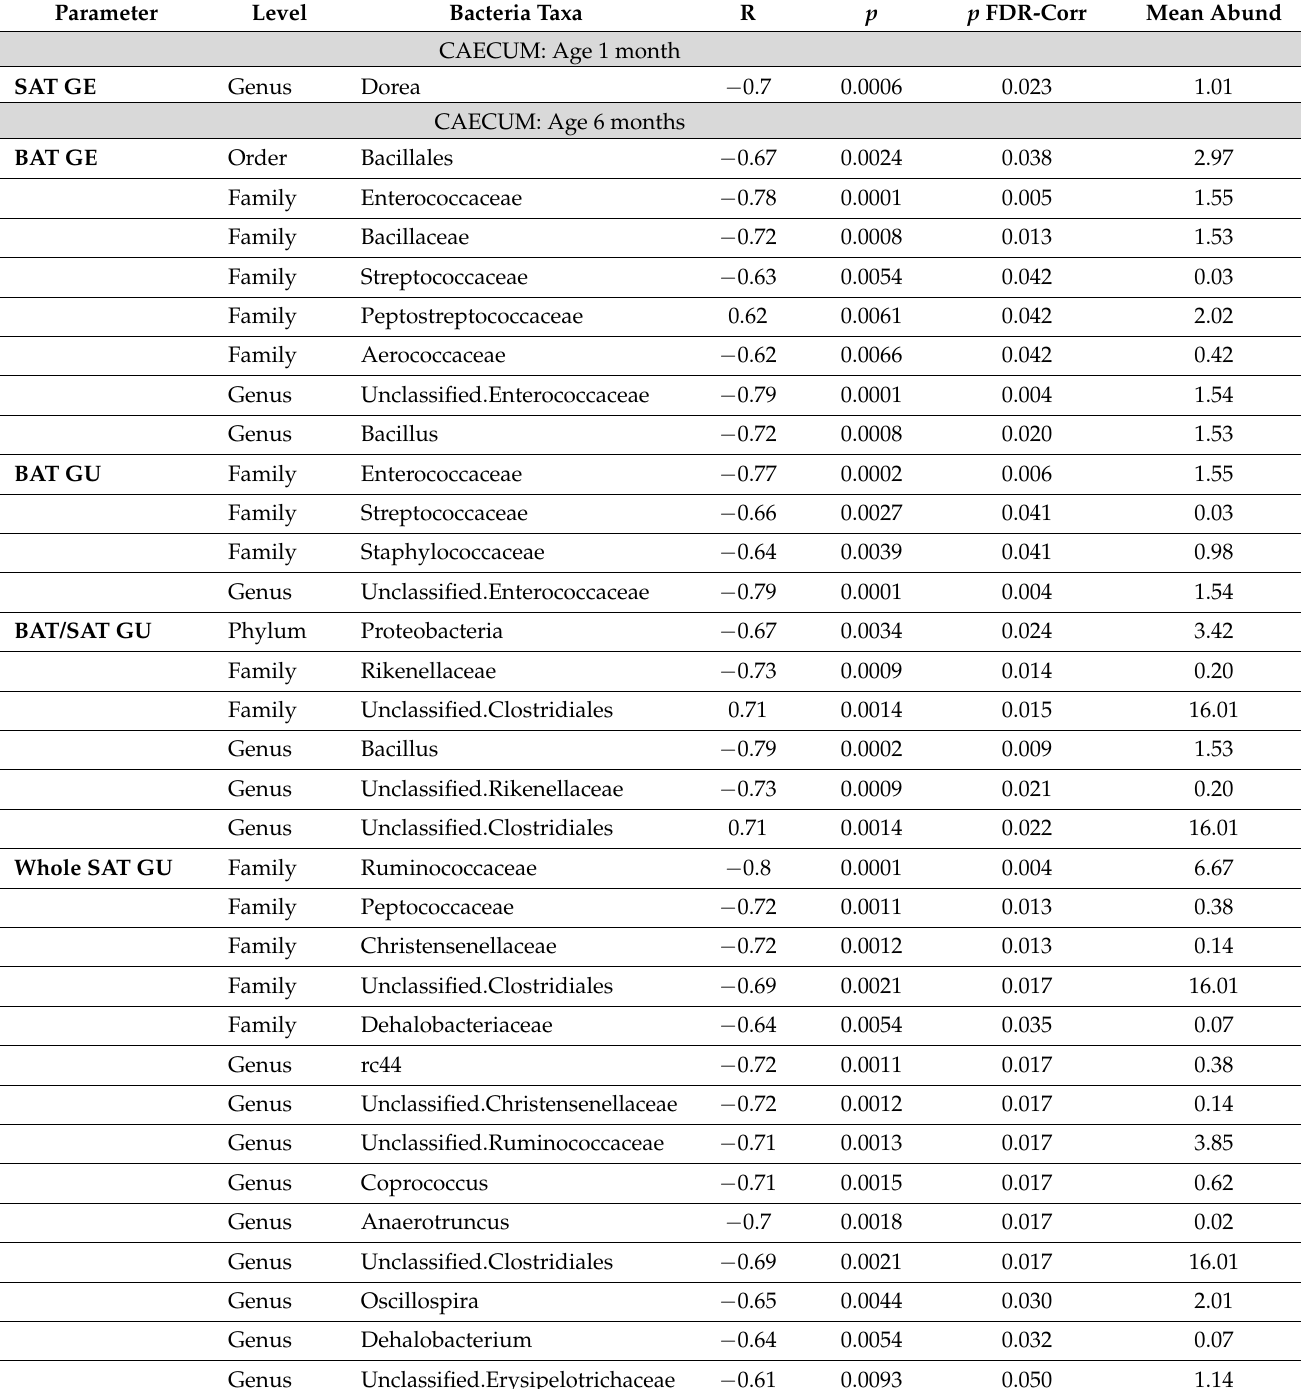
Table 2. Relationships linking imaging data and